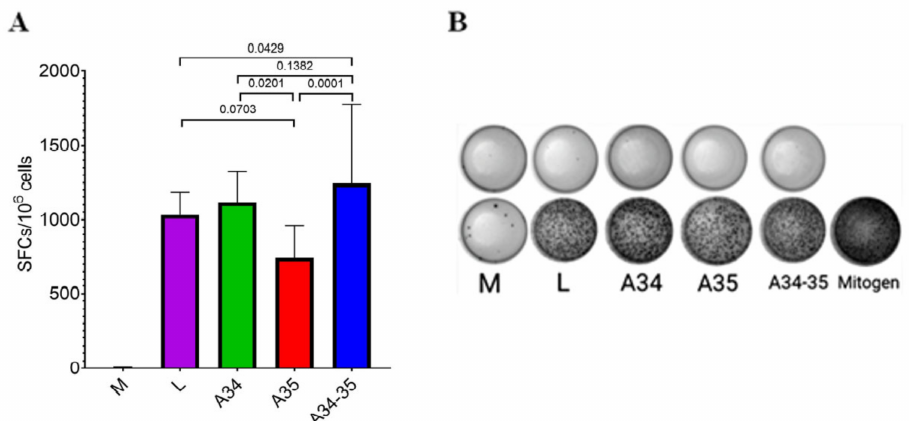
Figure 3. The results of the ELISpot assay of the VACV-specific T cell-mediated response in immu- nized BALB/c mice. M—control (non-immunized) mice; L—the VACV LIVP strain; A34—LIVP- A34R*; A35—LIVP-dA35R; and A34-35—LIVP-A34R*-dA35R. ( A ) The number of cells expressing IFN- γ in response to stimulation with a pool of VACV-specific peptides, per 1 × 10 6 splenocytes. The diagrams show the median values and the range. Statistical analysis was performed using the GraphPad Prism 9.0 software. Intergroup differences in immune responses were assessed with the non-parametric one-way Kruskal–Wallis analysis of variance adjusted for multiple comparisons used Dunn’s statistical hypothesis testing. The p values are indicated above the horizontal brackets. ( B ) The representative images of ELISpot wells (the top row: splenocytes not stimulated by peptides; the bottom row: splenocytes stimulated with peptide pool or a